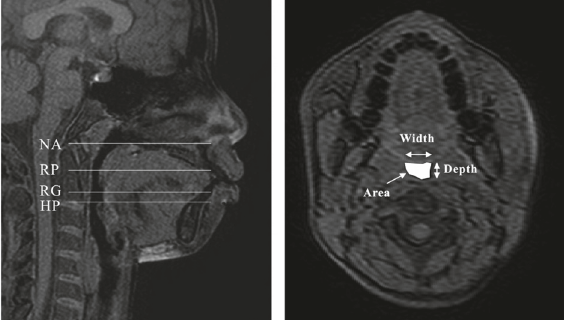
Figure 3: Landmarks and measurements of the upper airway on MRI. The nasopharynx (NA) was measured on the axial cross- section of the airway passing through the palatal plane. The retropalatal oropharynx (RP) was measured on the axial cross- section of the airway with the minimum area, between the palatal plane and thetip of theuvula. Theretroglossal oropharynx (RG) was measuredontheaxialcross-sectionoftheairwaywiththeminimum area, between the tip of the uvula and the tip of epiglottis. The hypopharnx (HP) was measured on the axial cross-section of the airway passing through the tip of